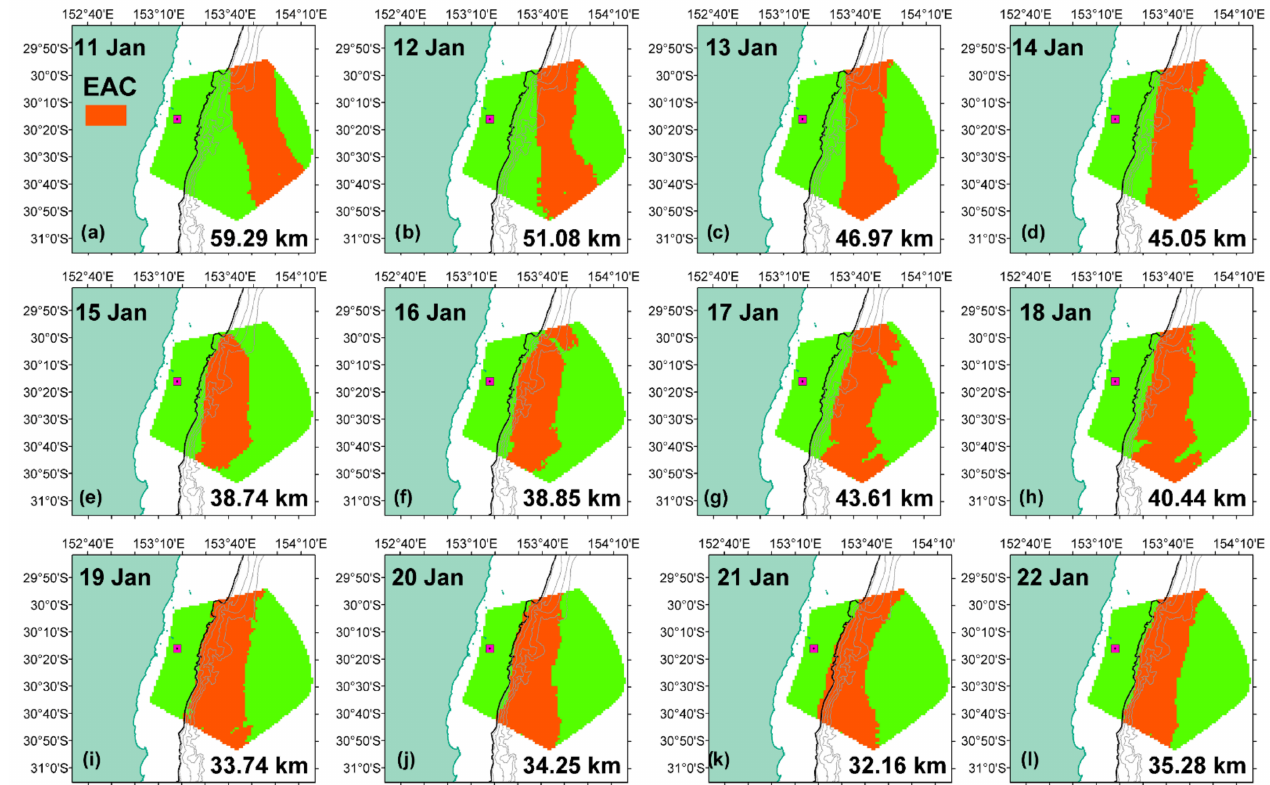
Figure 4. EAC’s speed signature maps and the corresponding EAC-to-coast distance (km) from 11–22 January 2016 ( a – l ). The line and point symbols are as in Figure 1. The black line denotes the shelf break.